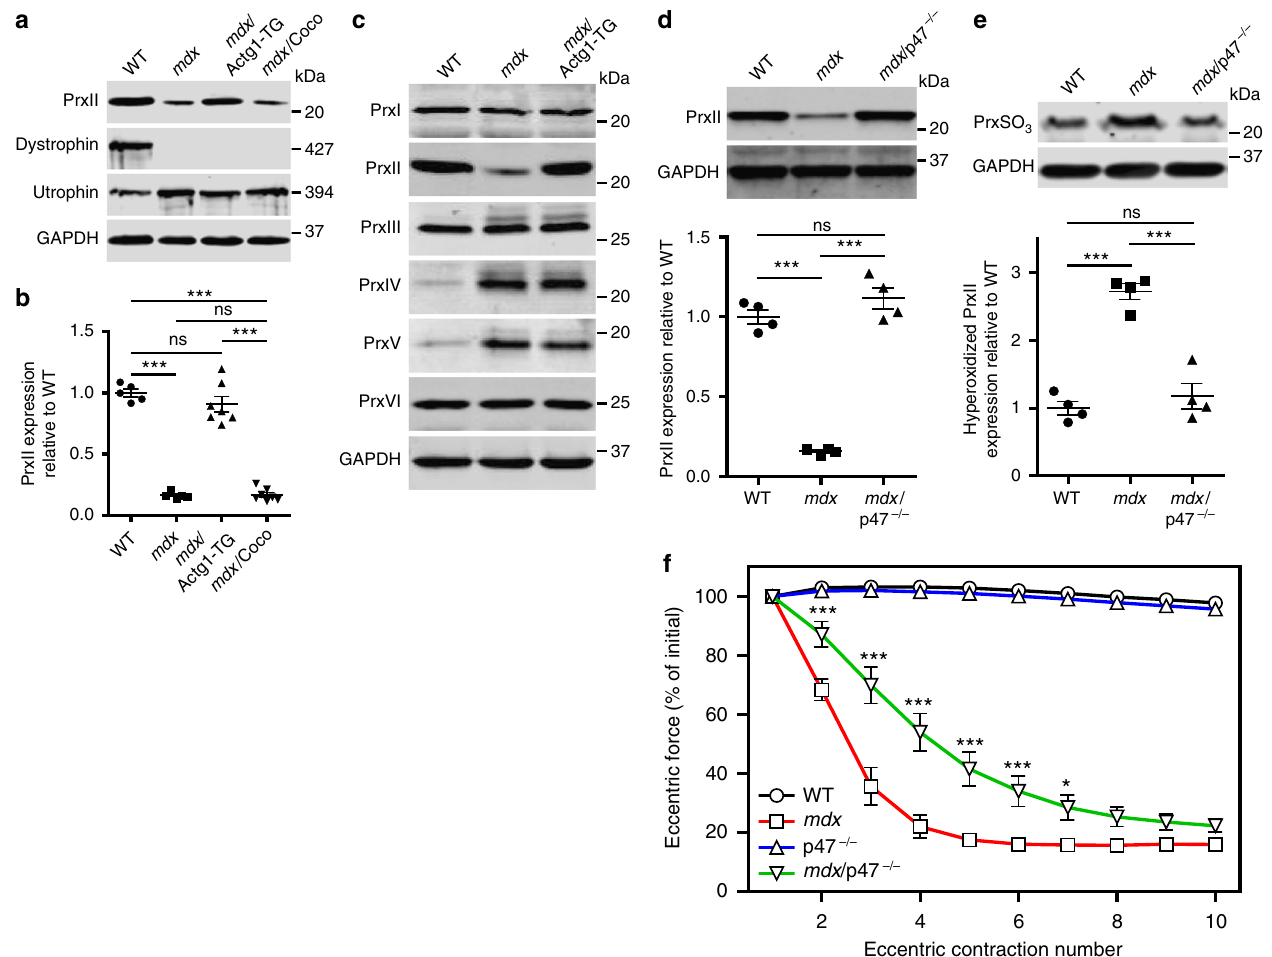
Fig. 2 Peroxiredoxin-2 is signi fi cantly decreased in mdx skeletal muscle and restored by γ cyto -actin overexpression and genetic ablation of NOX2 activity. a Immunoblot analysis of PrxII, dystrophin, utrophin, and GAPDH in WT, mdx , mdx /Actg1-TG, and mdx /Coco gastrocnemius muscles. b Immunoblot quantitation demonstrated that PrxII levels in mdx skeletal muscle were 16.5 ± 0.03% of WT and restored in mdx /Actg1-TG muscle to levels not different from WT, but not in mdx /Coco muscle; n = 5 for WT and mdx; n = 7 for mdx Actg1-TG and mdx /Coco. *** P < 0.001, ns no signi fi cance; one-way ANOVA. c Immunoblot analysis of peroxiredoxins 1 – 6 in gastrocnemius muscles from WT, mdx , and mdx /Actg1-TG mice. PrxII was the only peroxiredoxin isoform that was both altered in mdx compared to WT, and also restored to its WT level by muscle-speci fi c γ cyto -actin overexpression. d Immunoblot analysis of PrxII in WT, mdx , and mdx /p47 – / – gastrocnemius muscles demonstrated a restoration of PrxII to WT levels in mdx /p47 – / – muscle; n = 4 for each genotype. *** P < 0.001, ns no signi fi cance; one-way ANOVA. e Immunoblot analysis demonstrated signi fi cantly elevated hyperoxidized peroxiredoxin (PrxSO 3 ) in mdx compared to WT, and restored to WT levels in mdx /p47 – / – gastrocnemius muscles; n = 4 for each genotype. *** P < 0.001, ns no signi fi cance; one-way ANOVA. f EDL muscles isolated from WT, mdx , p47 – / – , and mdx /p47 – / – mice were subjected to 10 eccentric contractions and the forces measured expressed as a percentage of the force generated during the fi rst eccentric contraction; n = 4 for WT and mdx ; n = 3 for p47 – / – ; n = 7 for mdx /p47 – / – . * P < 0.05, *** P < 0.001 compared to mdx ; two-way ANOVA. Throughout, error bars represent means±